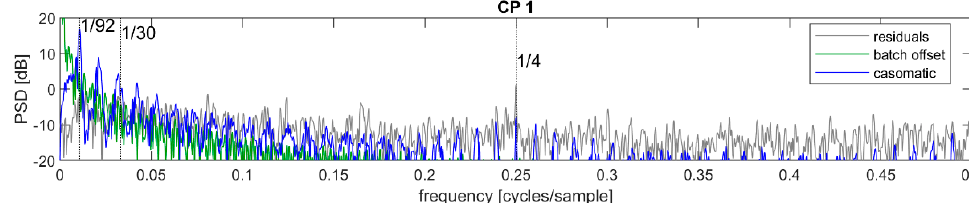
Figure 5. Power spectral density at CP1 for the 2022 data. The unit is in the logarithmic scale of decibel (dB) which implies a factor 10 for each increase by 10 dB.